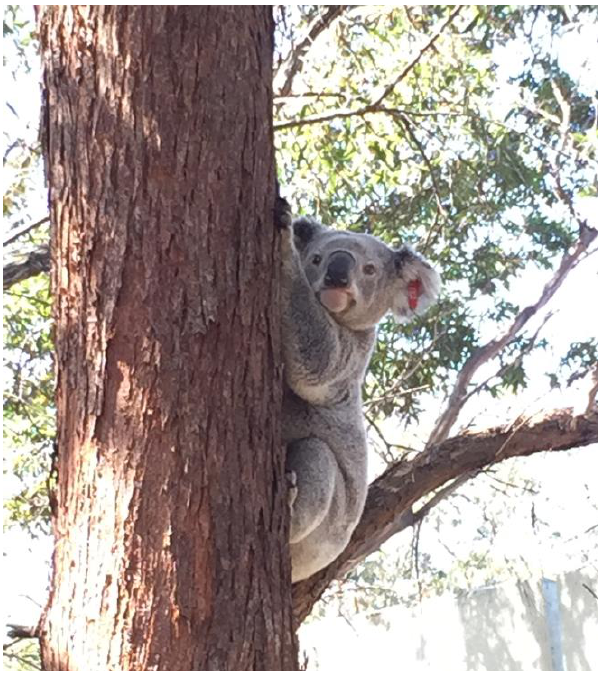
Figure 1. Koala sighting submitted by a volunteer.